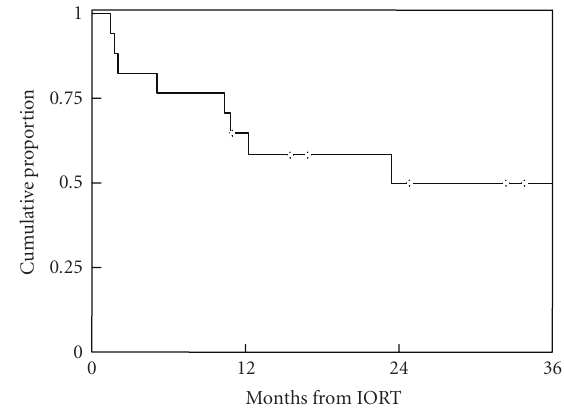
Figure 2: Disease-free survival. Kaplan-Meier probability esti- mates. Two patients failed locoregionally, 6 patients failed distantly, and 1 patient died without recurrence.